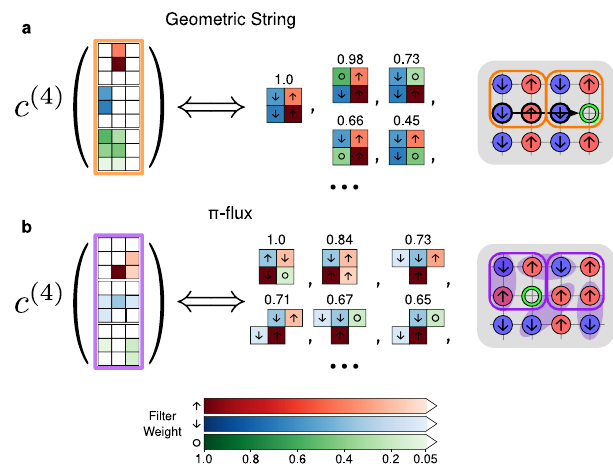
Fig. 4 Extracting four-point correlators from learned fi lters. a , b The highest-weight terms of Eq. (2) when constructing correlator features c ð 4 Þ ; c ð 4 Þ from the discovered convolutional fi lter patterns f 1 , f 2 . We ignore 1 2 correlators with two or more holes, since these motifs are exceedingly rare in the low-doping regime. Each feature c ð 4 Þ α measures a weighted sum of the bare correlators drawn on the right-hand side, obtained by selecting all four-pixel subpatterns from the learned fi lters. Due to the symmetrization procedure, the model measures all correlations which are symmetry-equivalent under rotations and fl ips to those drawn. Weights shown above each correlator are obtained as the product of the component fi lter pixel weights, normalized such that the largest correlator from each fi lter has weight